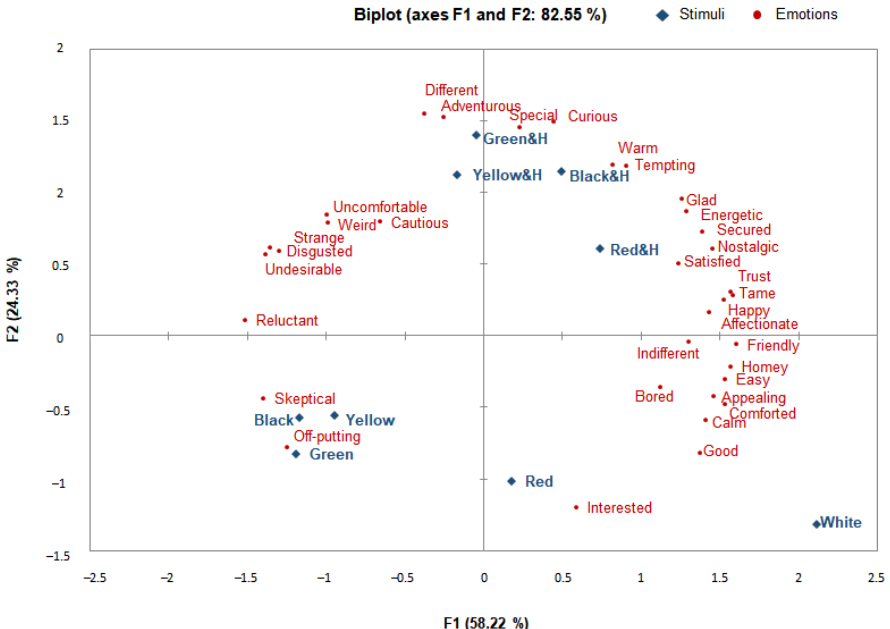
Figure 3. PCA biplot showing the emotion profile elicited by the CO and CO&H of colored rice in the American respondents.